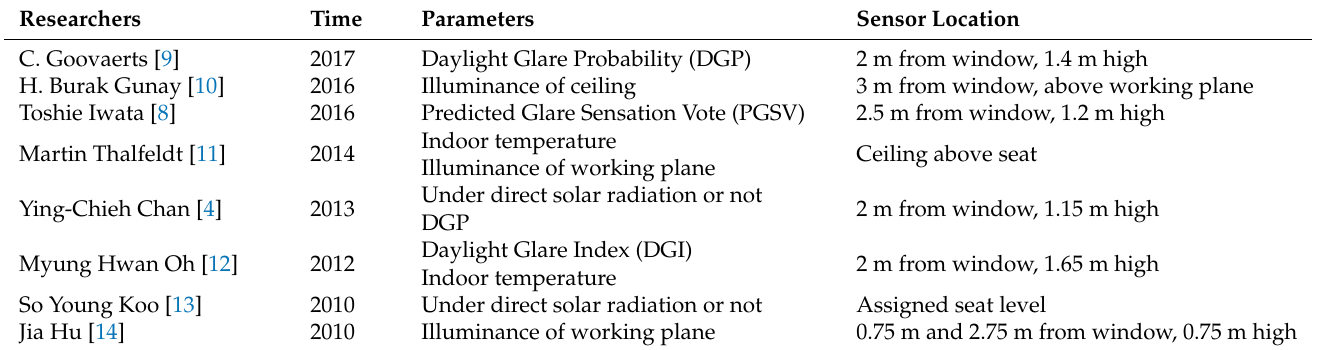
Table 1. Sensor location information of domestic and international automatic shading control logic in recent